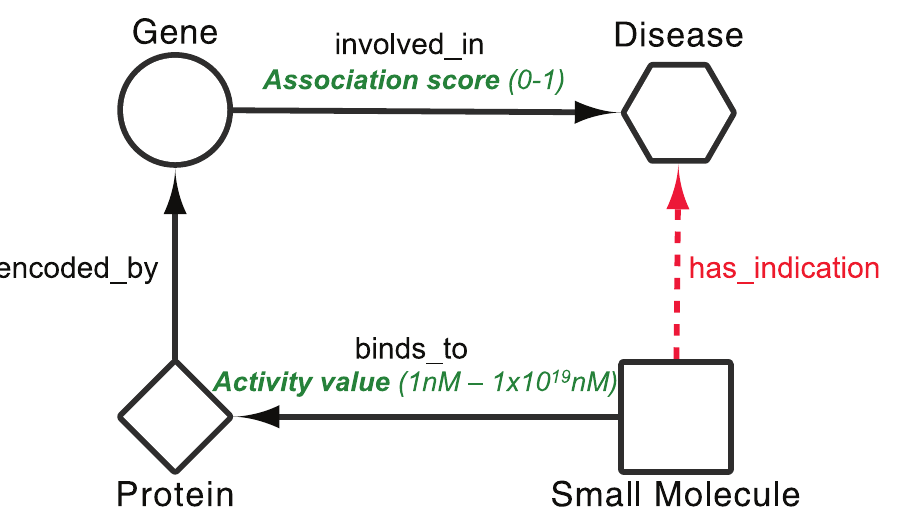
Fig 3. Semantic subgraph used during mining of the integrated network. Subgraph represents the simplest approach to schematically represent the route from drug to disease using target-based approaches to drug repositioning. Through identifying mappings of the subgraph in our integrated dataset we aim to infer the red has_indication relations. Mappings are scored using the values captured in the Activity value and Association score attributes (shown in green) found on the binds_to and the involved_in relations, respectively. Note : in mappings ‘ Disease ’ can be either a Common_Disease or a Rare_Disease and a ‘ Drug ’ is an approved Small_Molecule